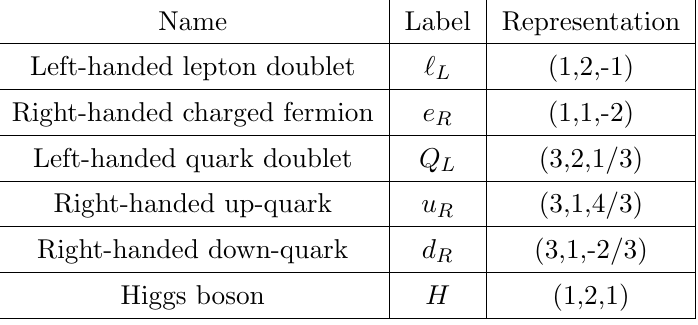
Table 1 . The Standard Model fermion and scalar